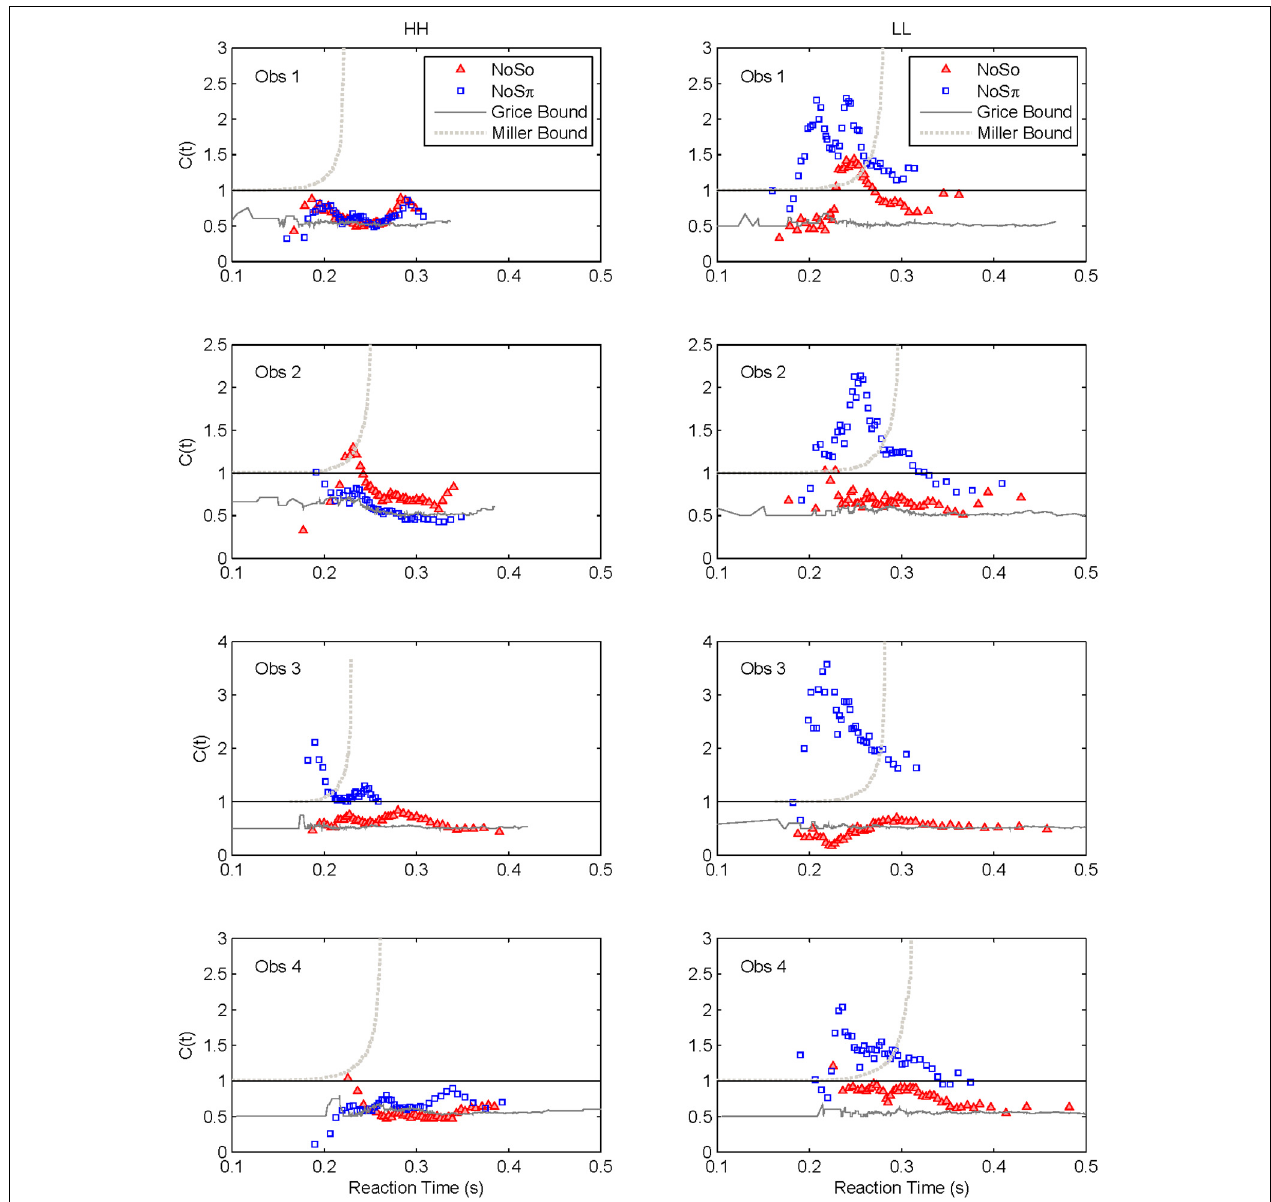
FIGURE 8 | Capacity functions for the two contexts are shown for HH and LL